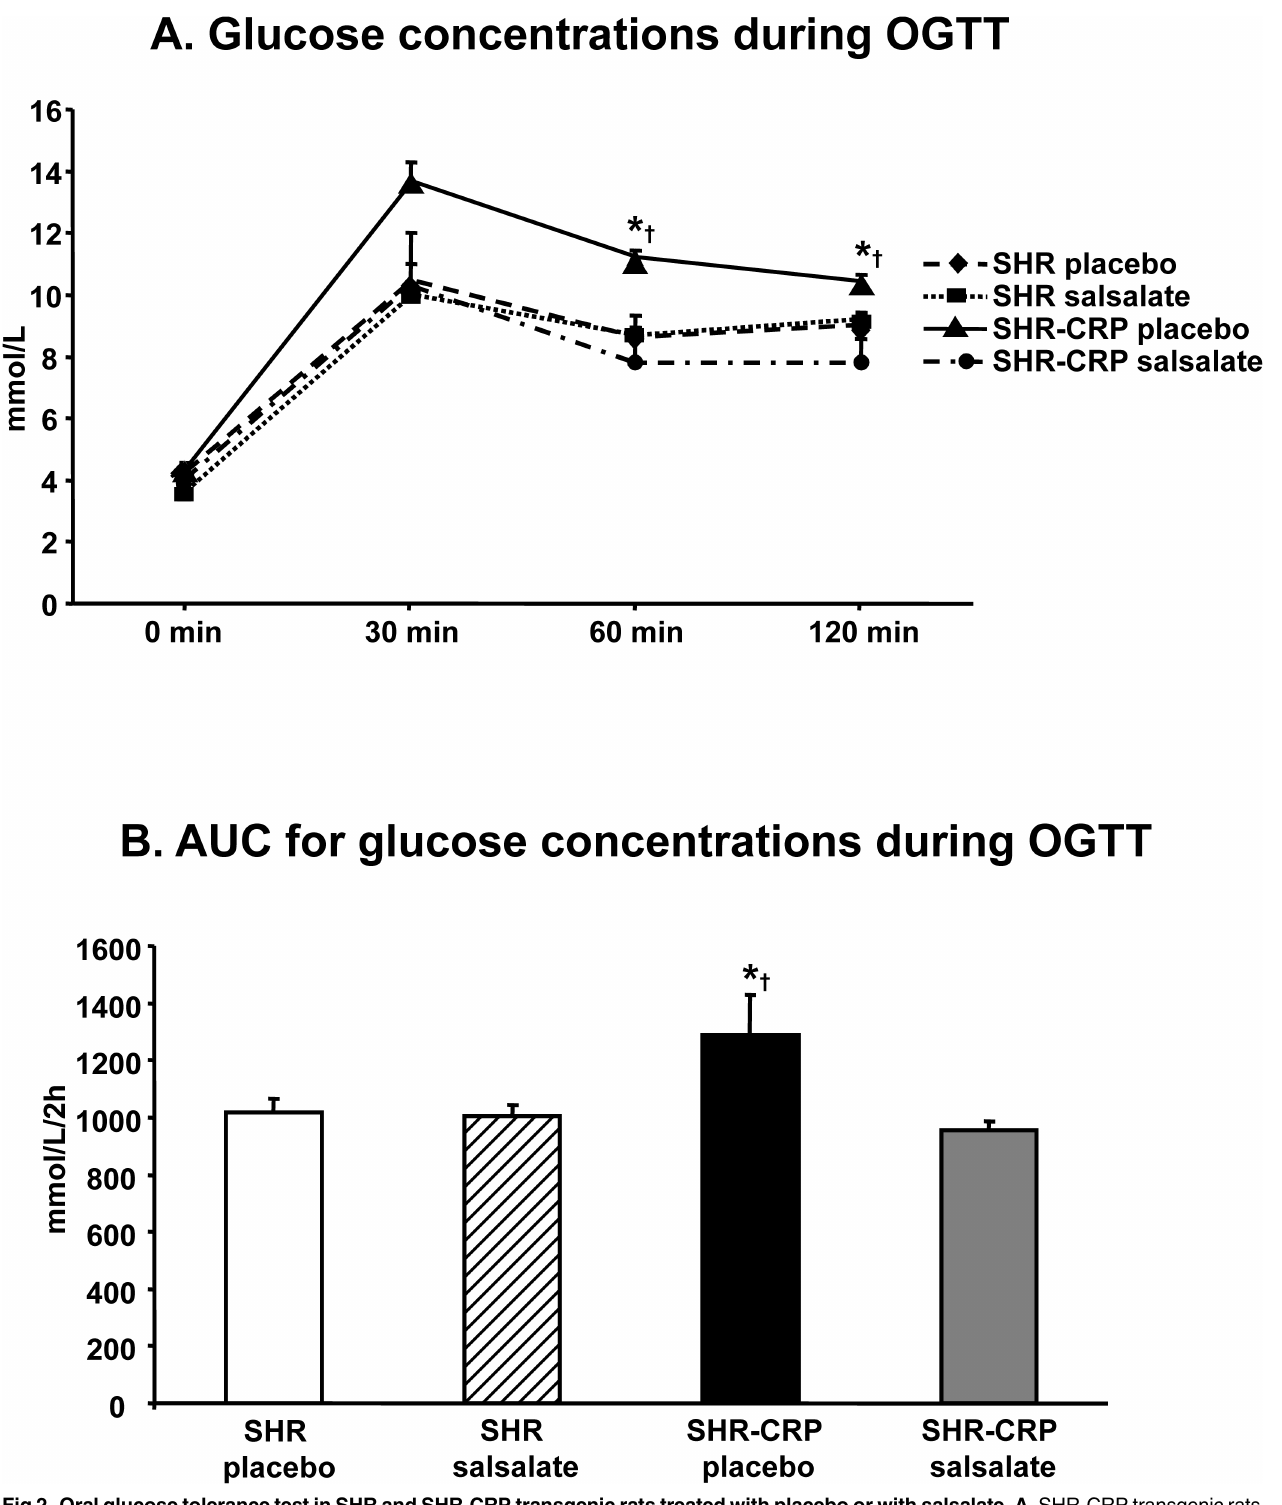
Fig 2. Oral glucose tolerance test in SHR and SHR-CRP transgenic rats treated with placebo or with salsalate. A. SHR-CRP transgenicrats treated with salsalateexhibitedsignificantly reducedglucoseconcentrations (similar to both treated and untreatedSHR rats) when comparedto SHR-CRP rats treated with placebo. No significanteffects of treatment were observed in nontransgenic SHR rats. B. Area under the curve (AUC) for glucoseconcentrations in SHR-CRP rats treated with salsalatewas significantly reducedwhen comparedto untreatedSHR-CRP rats. *